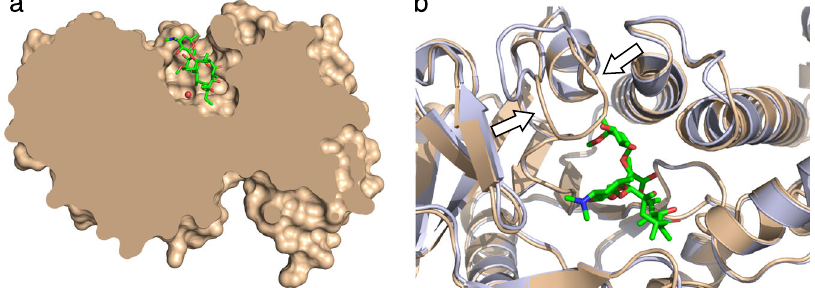
Fig. 4 Cross-section of EreC with emphasis on the fl exible loop. a A cut-through section of EreC Closed with docked erythromycin shows the depth of the catalytic pocket and the protein-ligand interface. b View rotated 90° along the horizontal axis, with EreC Closed colored in light brown and EreC Open colored in light blue. The active site loop is in two distinct conformation (arrows), which can cover the top of the active site and act as a